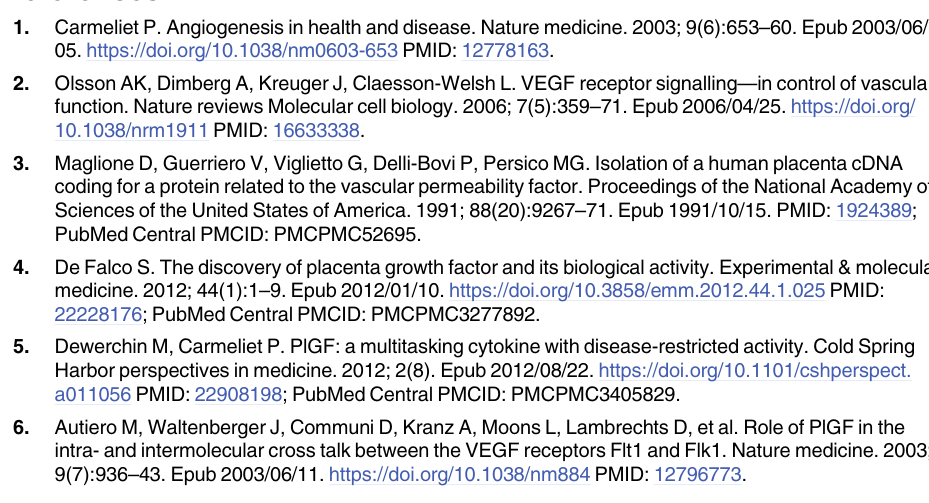
S1 Fig. No effects of STAT6 on the expression of PlGF and